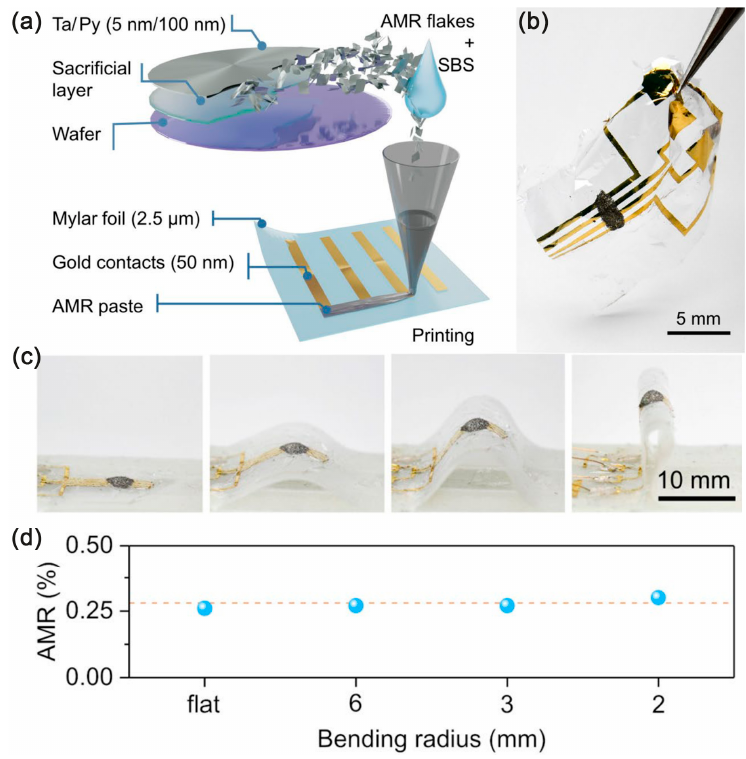
Figure 4. ( a ) Schematics on the fabrication process of printed AMR sensors; ( b ) Physical picture of the printed AMR sensor; ( c ) Photographs revealing the bending state of the sensor; ( d ) the respective AMR response measured at ±400 mT. Adapted with permission from Ref. [33] and licensed under CC BY 4.0. Copyright 2021, copyright Springer Nature Limited.